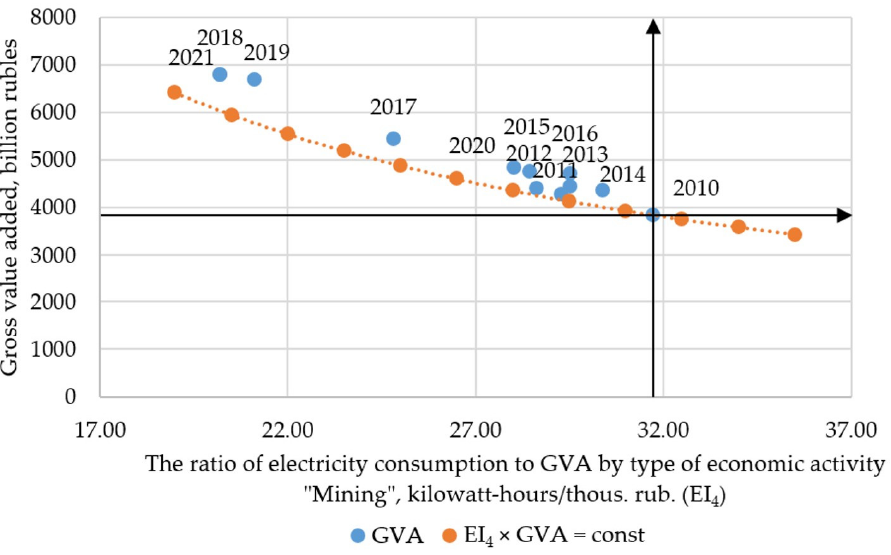
Figure 5. The color of environmental and economic development in terms of electricity consumption by type of economic activity “Mining” in the Russian Federation for the period 2010–2021.